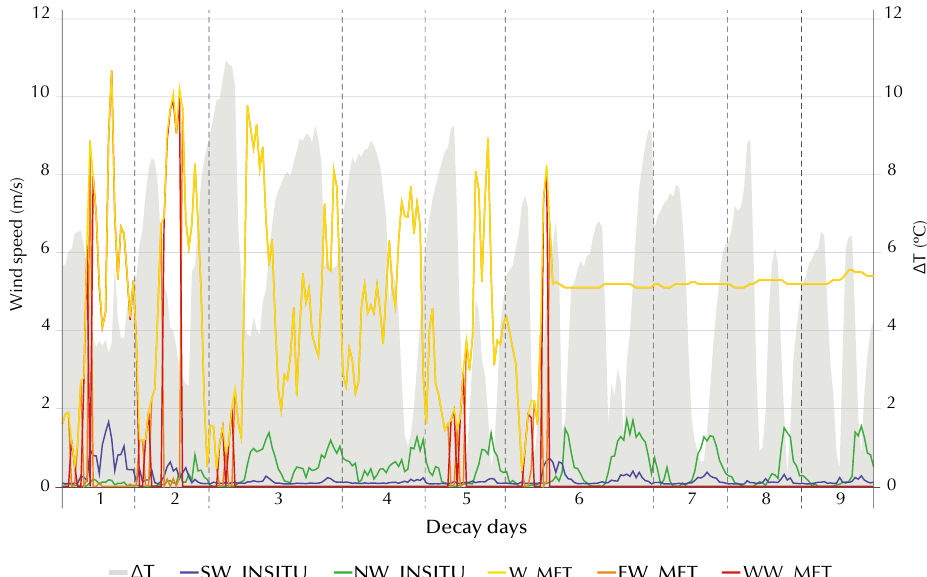
Figure 6. Wind speed and ∆ T averages of summer (P_1_T) at ten-minute time-step. This period presents higher wind and ∆ T variability, especially in the weather station’s wind data, according to which the wind speed sometimes exceeds 10 m/s.